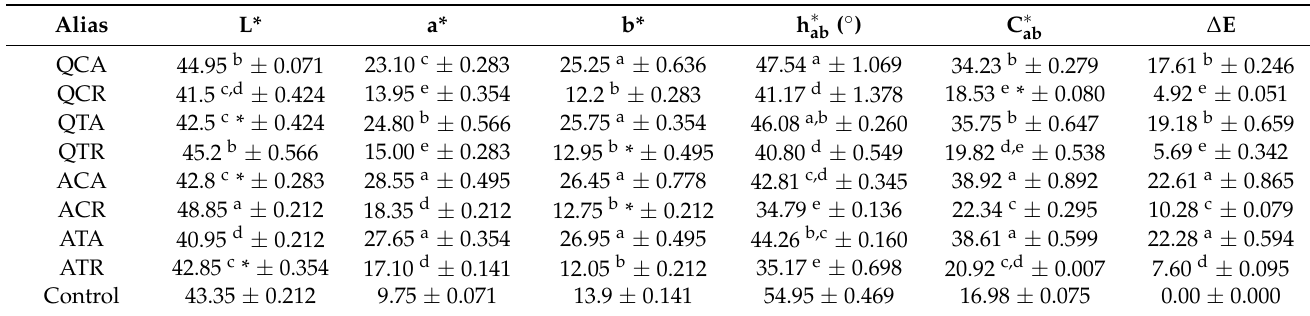
Table 4. Color parameters for raw formulations.